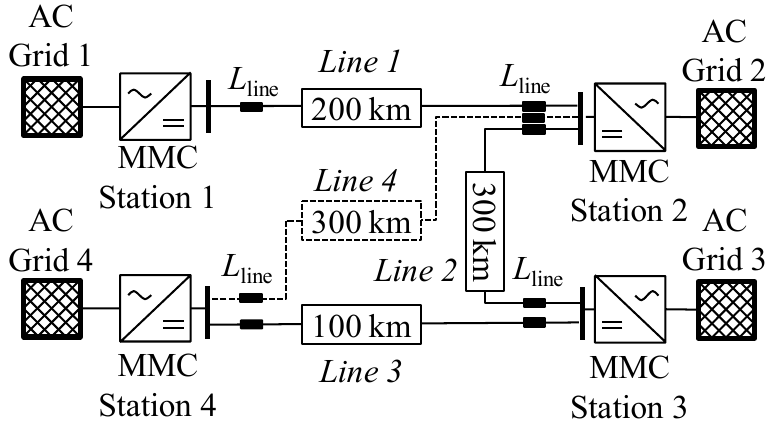
Figure 8. Investigated HVDC system.